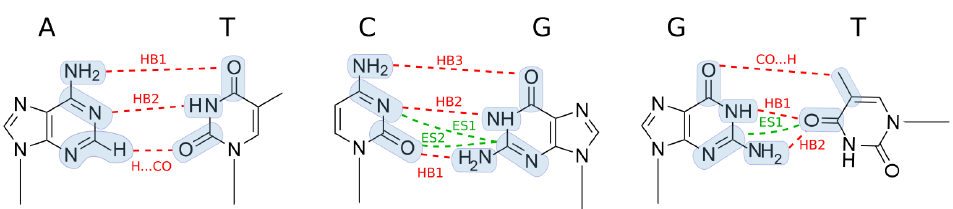
Figure 2. Three types of base pairs, adenine–thymine (A13:T18, regular), cytosine–guanine (C7:G24, regular), and guanine–thymine (G8:T23, mismatch). Hydrogen bonds (HB) and electrostatic (ES) interactions between functional groups (shadowed in grey) are labeled. See also Figure S3 for more